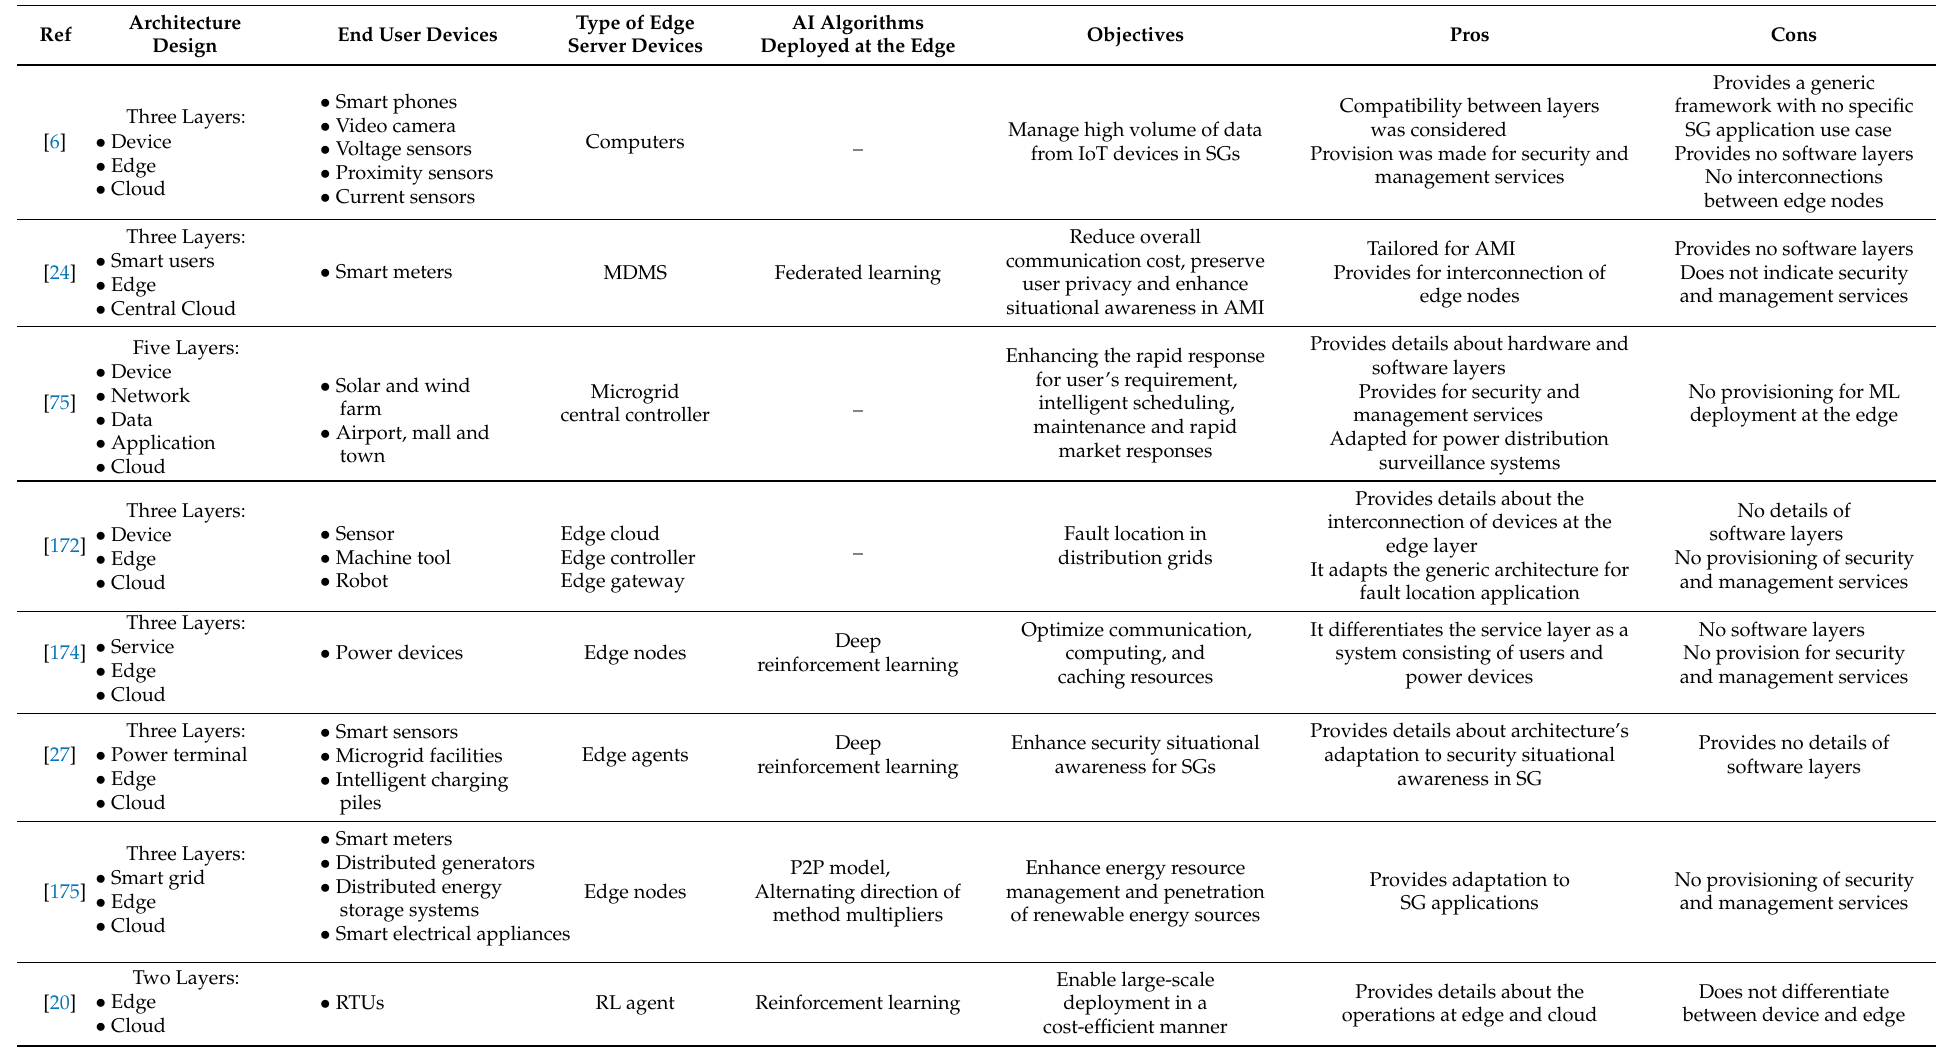
Table 4. Different Edge Intelligence Architectures and their characteristics for SG